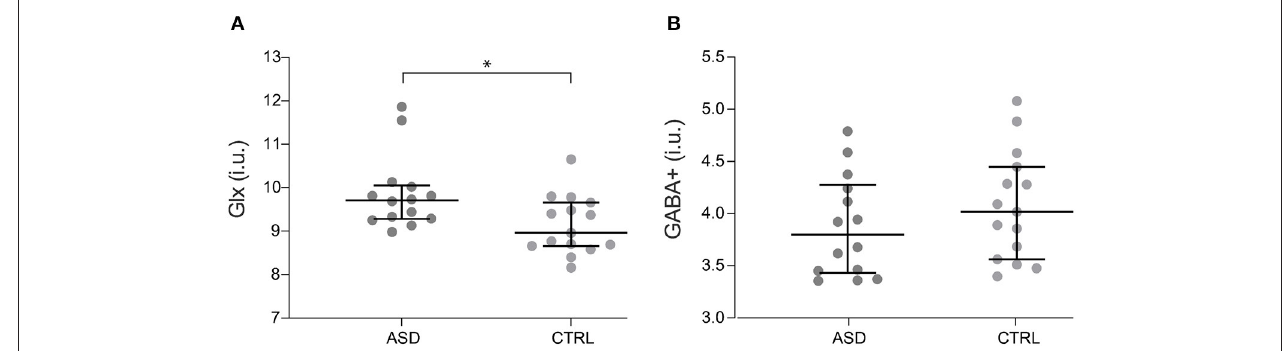
FIGURE 2 | Glx (A) and GABA + (B) levels for ASD ( n = 14) and control participants ( n = 15). Dots represent individual values and horizontal lines depict median and 95% confidence interval. * p < 0.05. ASD, Autism Spectrum Disorder group; CTRL, control group; GABA + , gamma-aminobutyric acid; Glx, glutamate + glutamine.